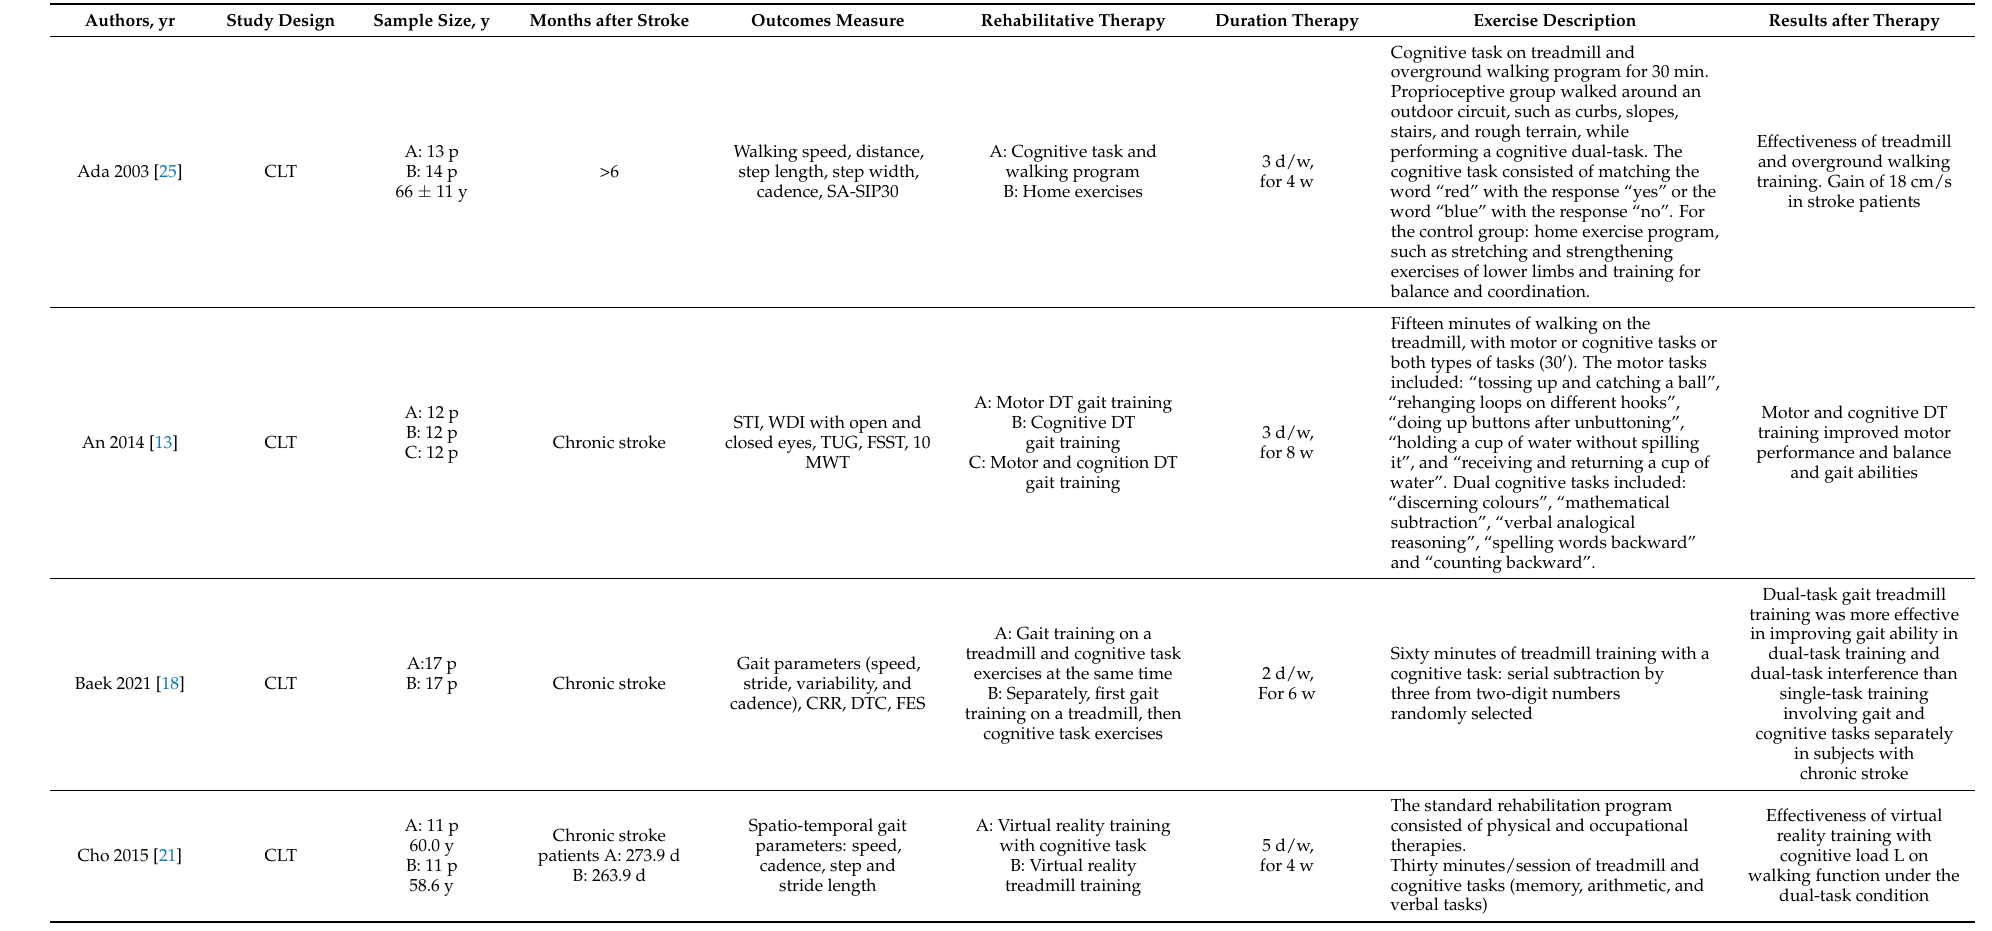
Table 1. Rehabilitation programs after stroke for postural imbalance, proprioception, and dual-task training. Characteristics and outcomes of studies included in the systematic review, according to PICOS criteria for inclusion of